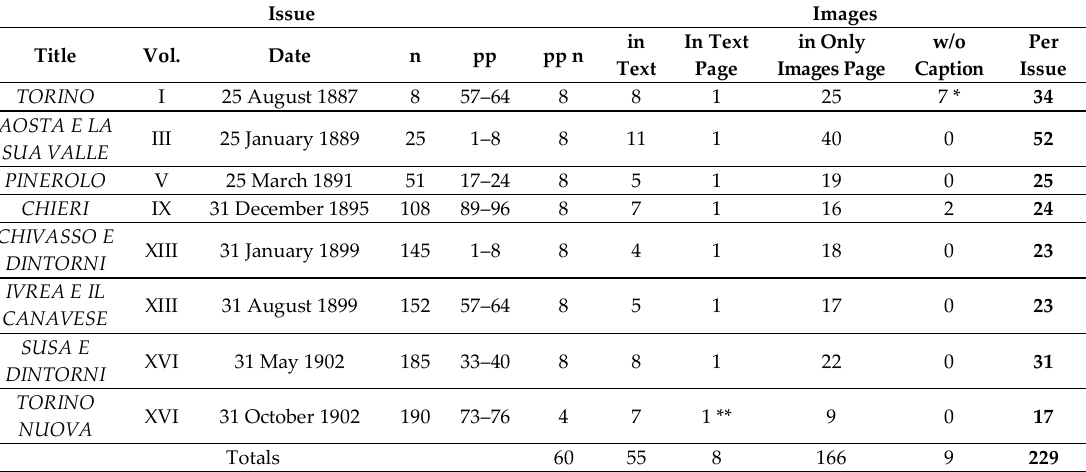
Table 2. Analyzed issues: images data